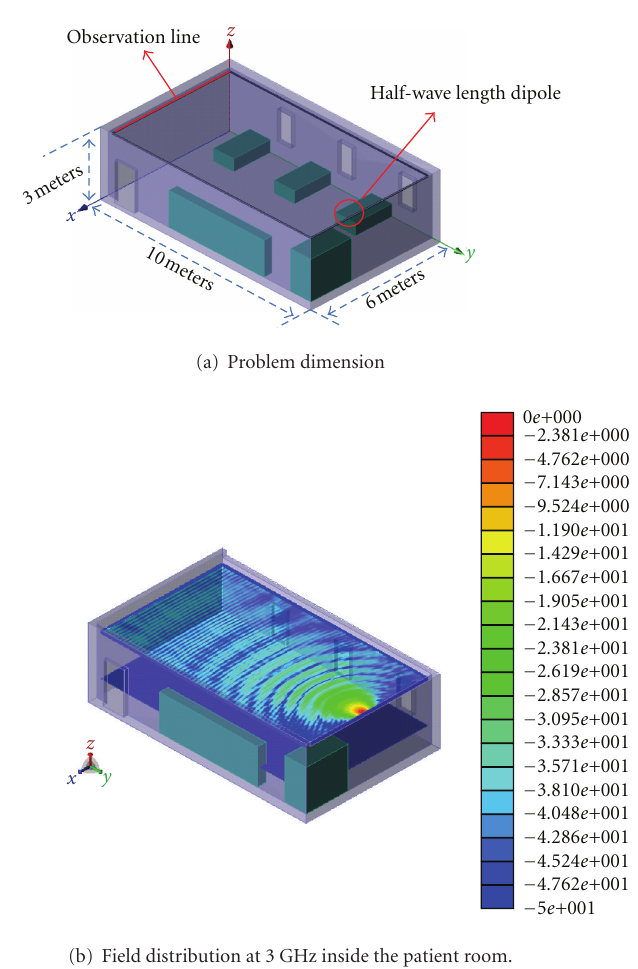
Figure 13: A typical patient room as an example to demonstrate the FDTD performance enhanced with SSE instruction set.